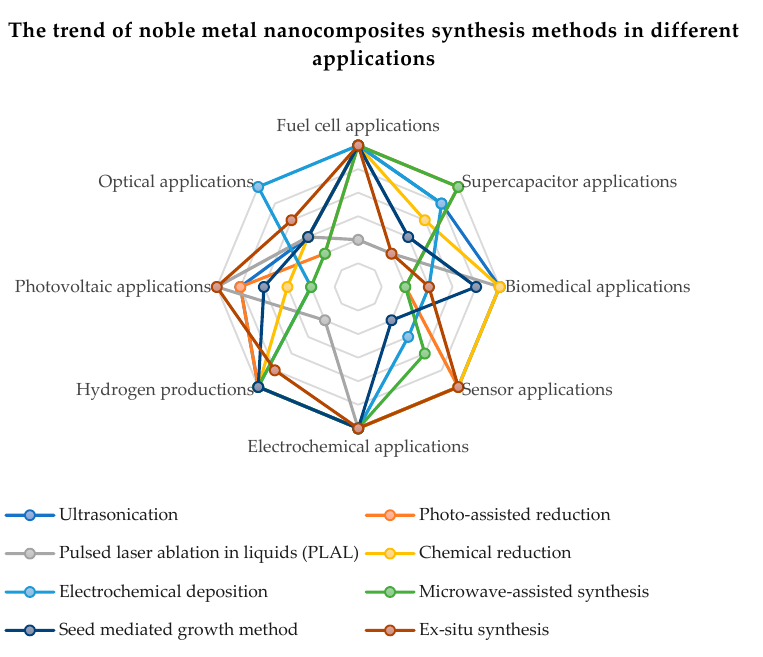
Figure 6. The trend of noble metal nanocomposites synthesis methods in different applications.